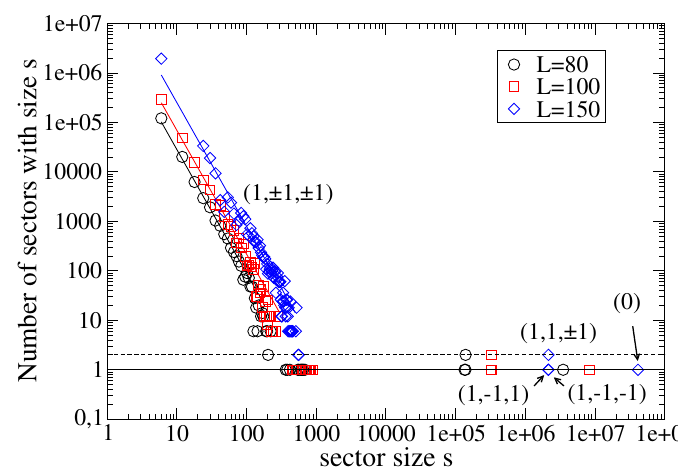
Figure 6: Distribution of sizes of Kempe sectors (log-log scale). It has a large num- ber of small sectors (smaller than ∼ L ) and five sectors around macroscopic values (the dashed line indicates two sectors). The five larger sectors are labeled by the in- variants found in section 4 (shown for L = 150, the two with ( 1, − 1, ± 1 ) are almost